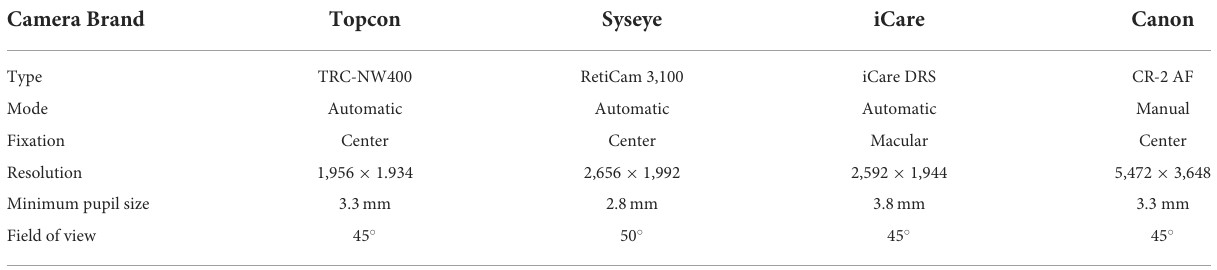
TABLE 2 Distribution of diseases and